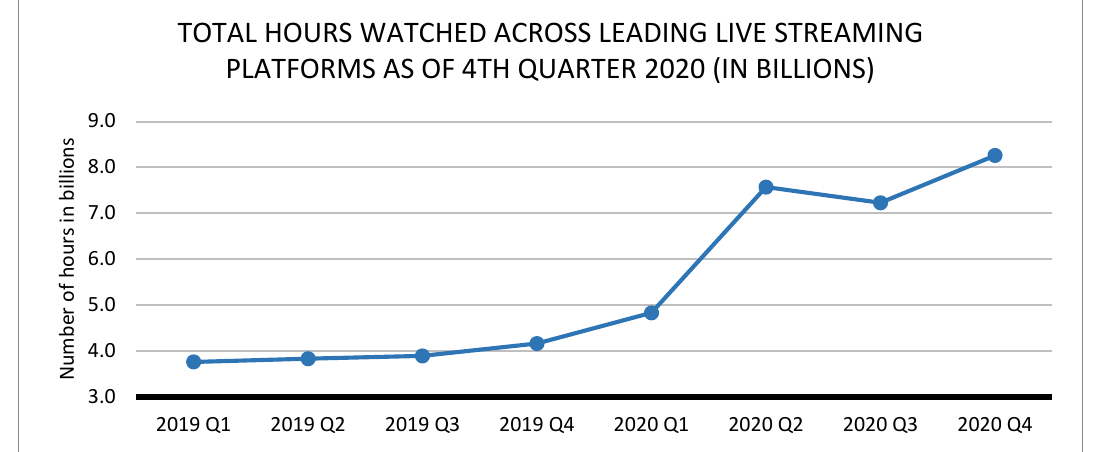
Figure 2. Total hours watched across leading live streaming platforms as of 4th quarter 2020 (in billions) [26].